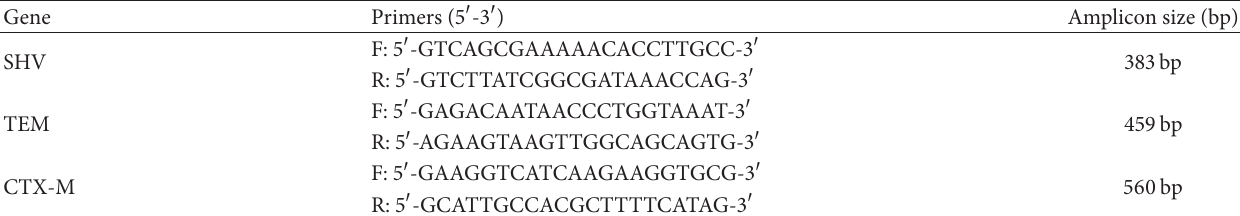
Table 2: Primers for the bla-CTX-M, bla-TEM, and bla-SHV genes.